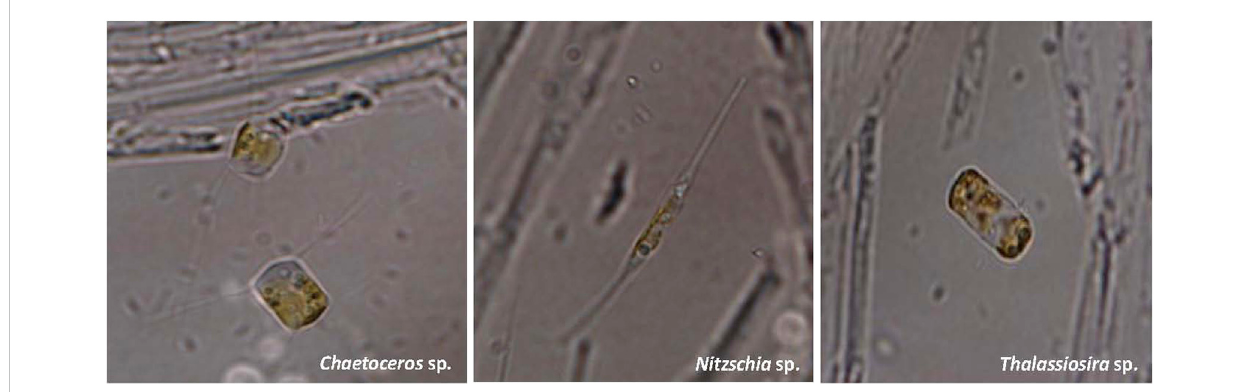
FIGURE 1 Fluorescence microscope images of Chaetoceros sp., Nitzschia sp., and Thalassiosira sp.